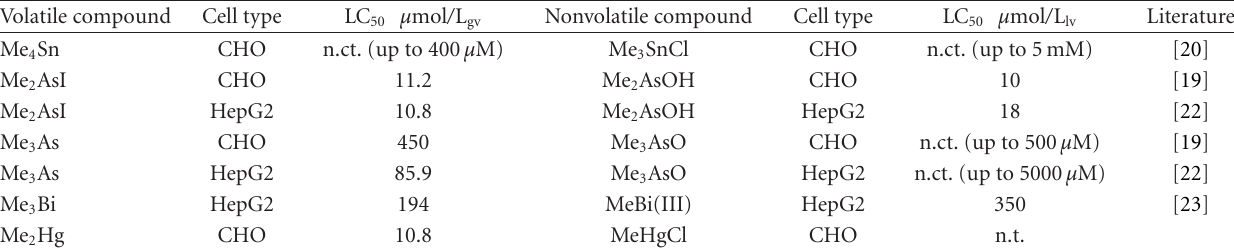
Table 3: Comparison of toxicity of volatile to nonvolatile species (exposure time: 1h; n.t.: not